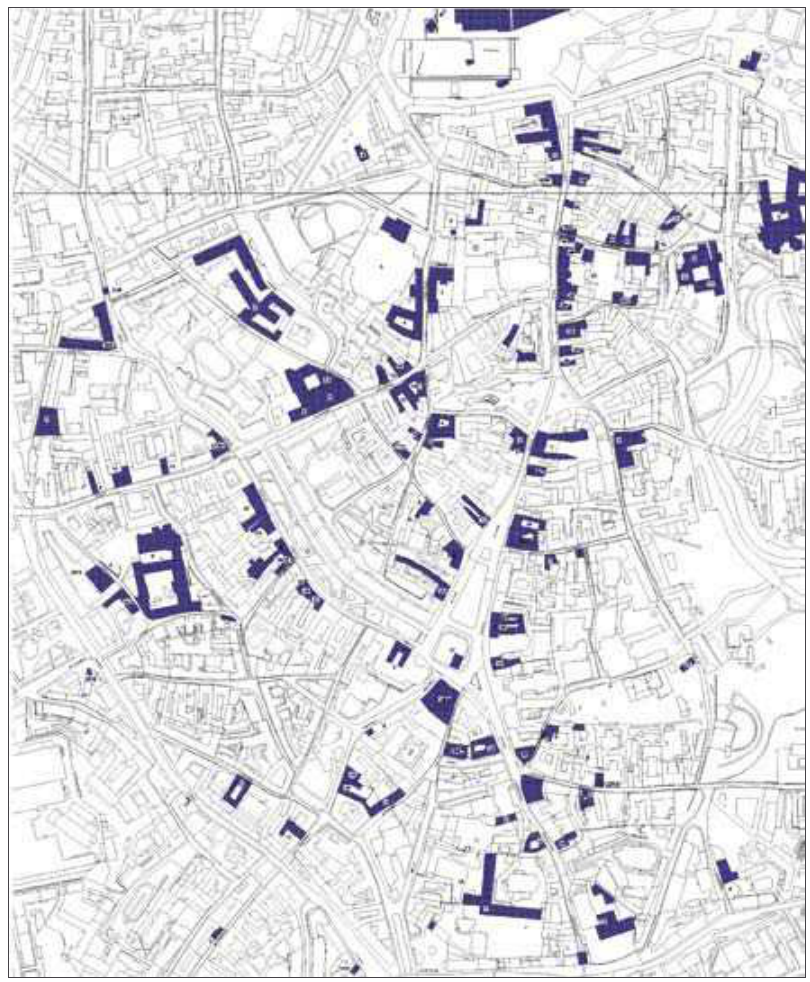
Fig. 7. Places in the central part of Vilnius, connected with construction and recons- truction influenced by r­enaissance movement